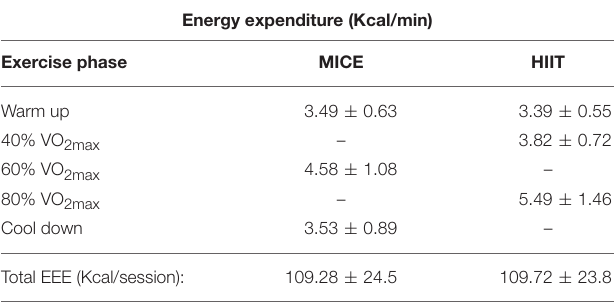
TABLE 3 | MICE and HIIT metabolic